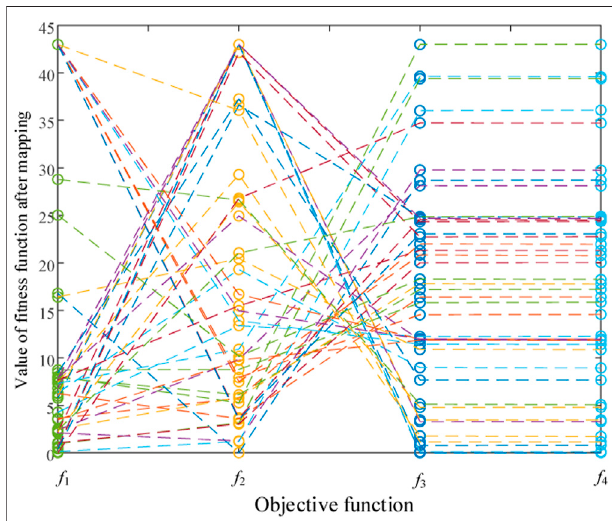
FIGURE 8 | Pareto front results.